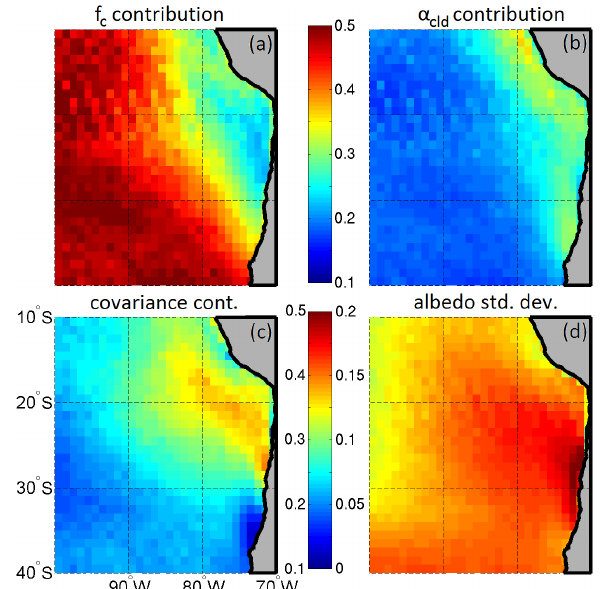
Fig. 3. Relative fractional contribution of terms in Eq. (5) to albedo time variance. The panels show the contributions from the first, second and third terms in the equation, and because the squared coefficients of variation of f c and α cld are small ( (cid:0) σ x x 0 < 1 , see Appendix A), the terms represent contributions from (a) f c variance, (b) α cld variance, and (c) the covariance between f c and α cld to albedo variance. These are all computed by dividing the corresponding terms by the sum of the absolute value of all terms. 4th order terms are not shown because their relative contribution is smaller ( ∼ 6–10%) over most of the domain (up to 21% in small localized regions south of 30 ◦ S). (d) is the albedo standard deviation.